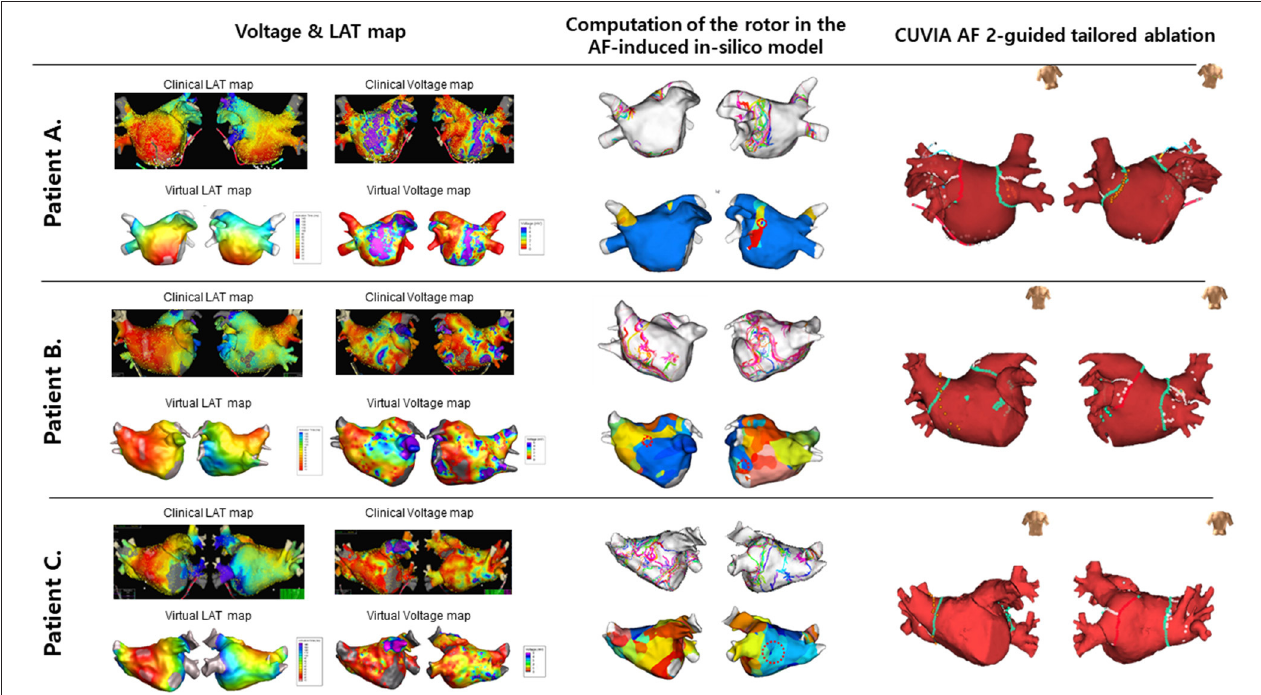
FIGURE 3 | Examples of the process to determine the CUVIA-AF ablation targets in three patients. (A) A 52-year-old man with DF located in the left inferior PV in the V-DF group. (B) A 56-year-old man with multiple DFs located on the anterior and posterior walls in the V-DF group. (C) A 72-year-old man with a DF located on the roof in the E-PVI